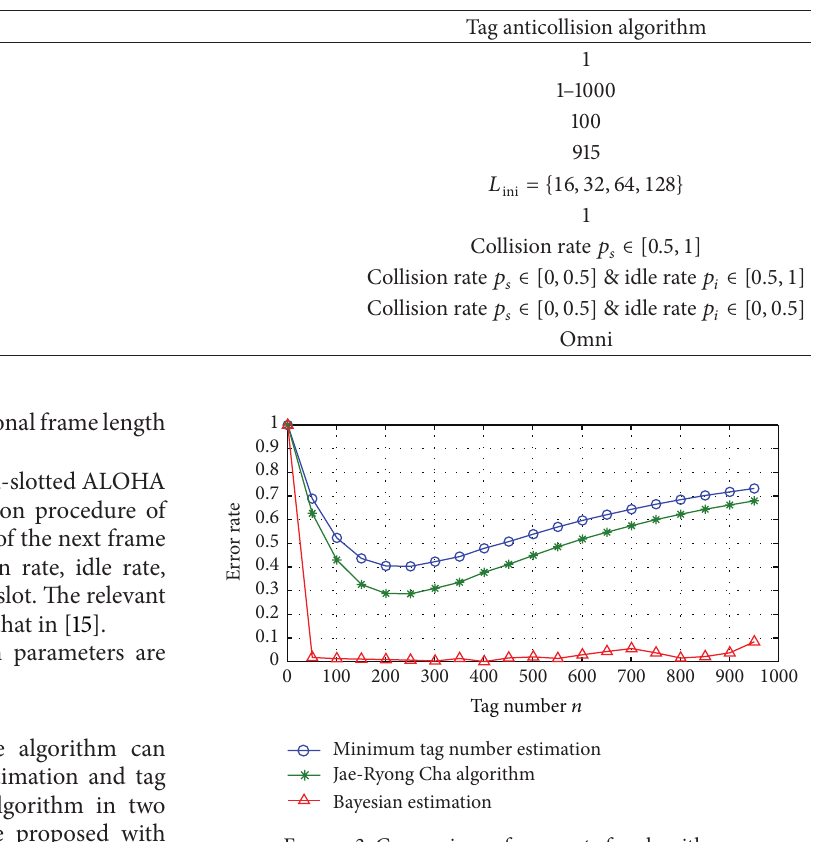
Table 1: Settings of the simulation parameters.